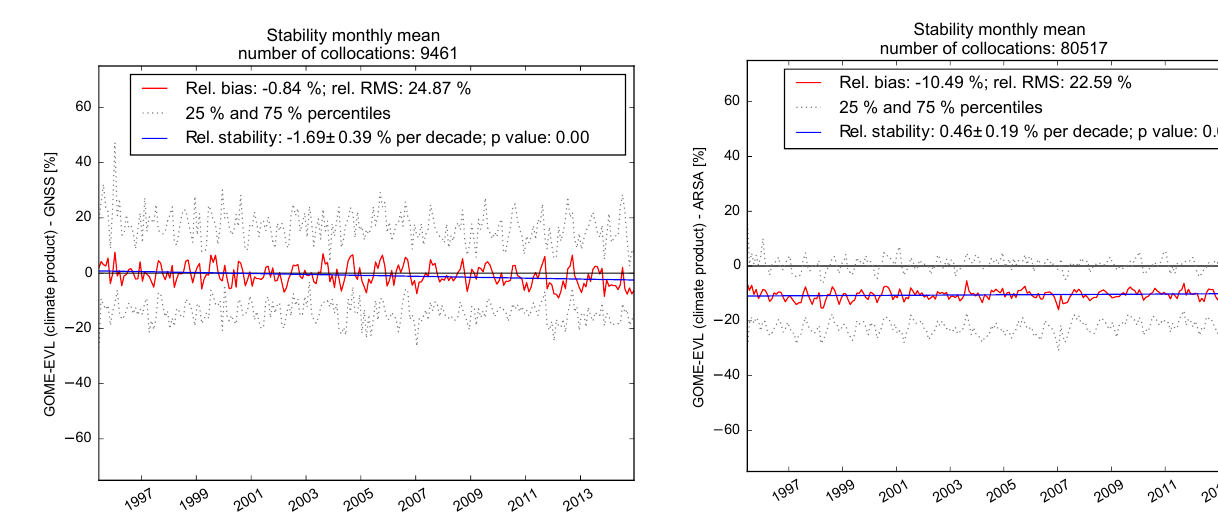
Figure 13. Time series of the relative difference between TCWV monthly means from the Climate product and GNSS stations. Only stations which were available for the whole time period are consid- ered. Figure from Danielczok and Schröder (2017).